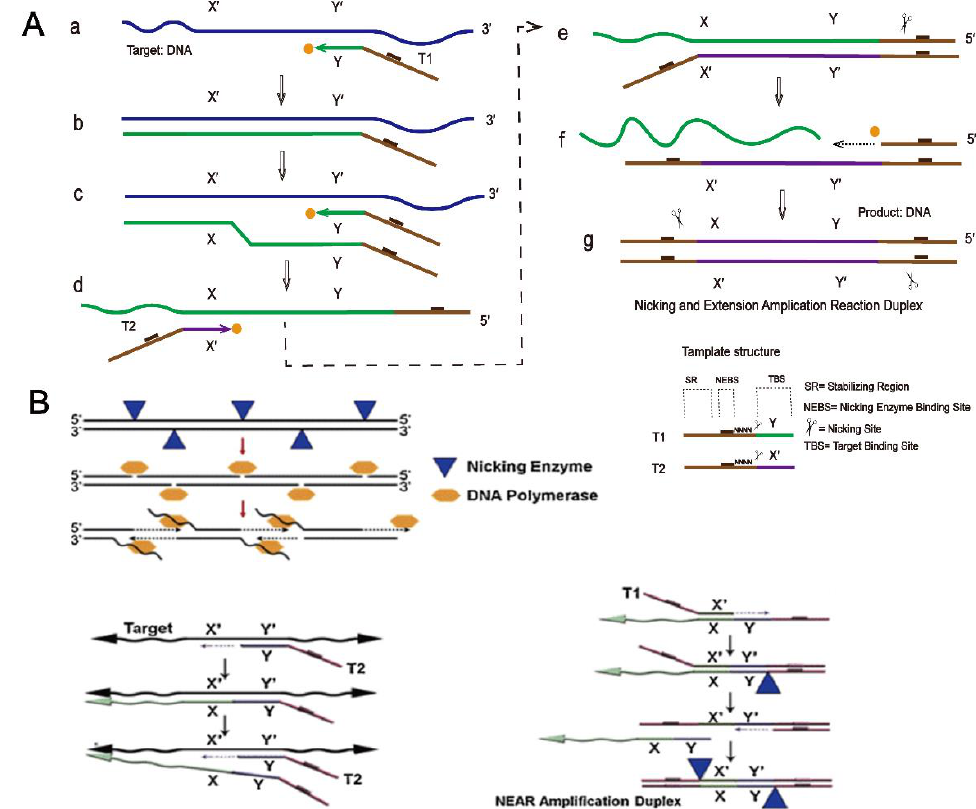
Figure 5. ( A ) Basic principle of nicking and extension amplification reaction. ( B ) Application of nicking and extension amplification reaction. (Reprinted with permission from Ref. [93]. Copyright 2014